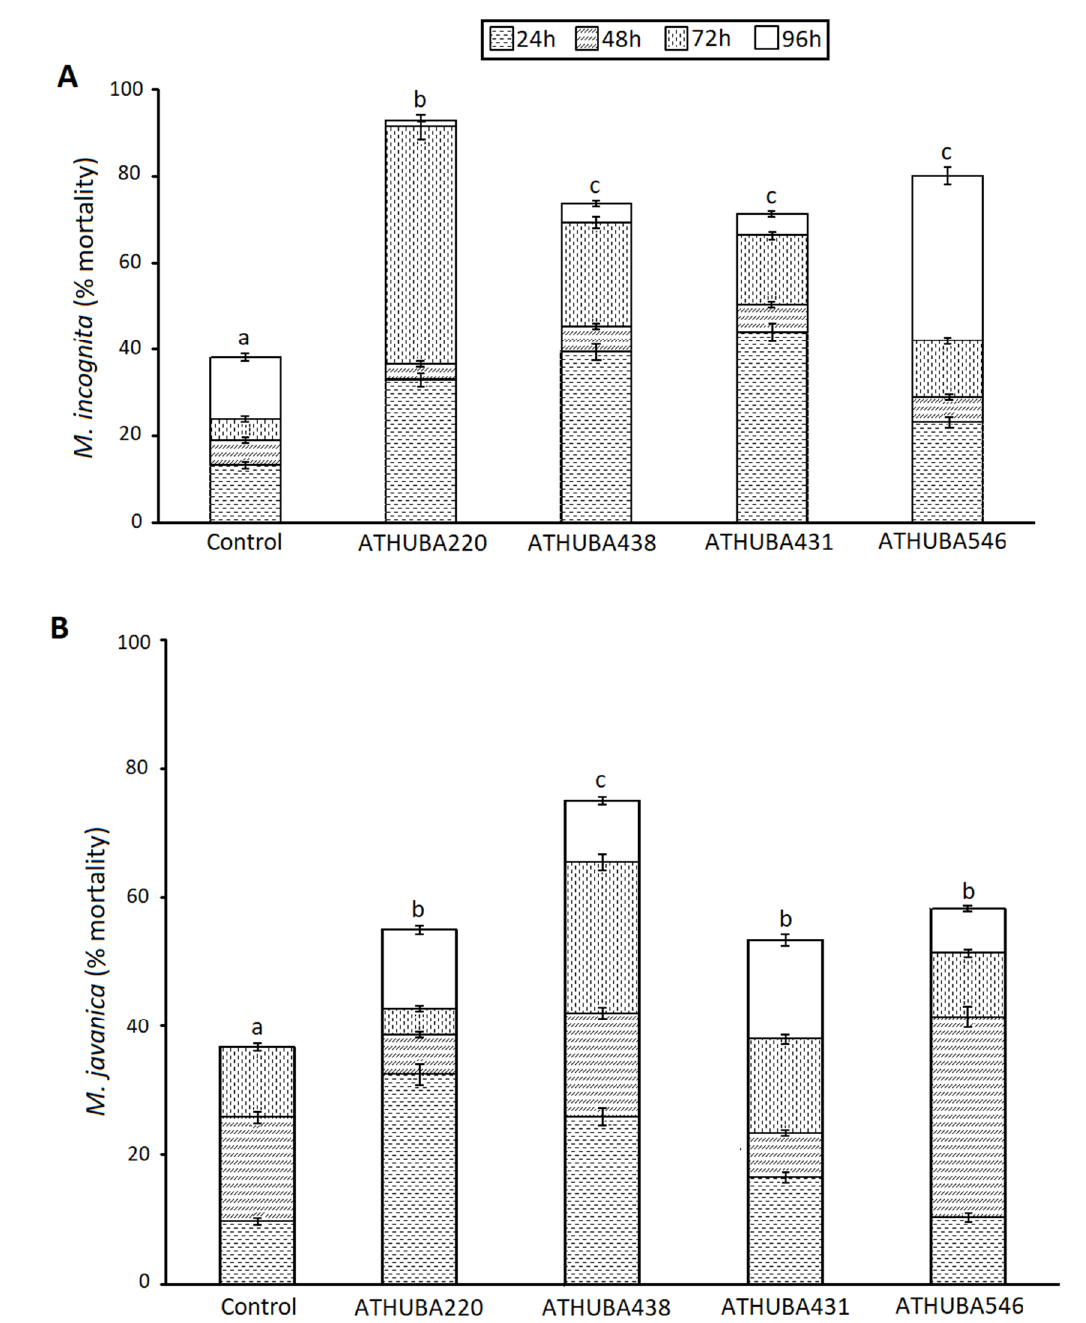
Figure 1. Percentage (mean ± standard error) of J2 mortality in Meloidogyne incognita ( A ) and M. javanica ( B ) after 96 h into batch culture supernatants of different Streptomyces strains as depicted. Different letters above columns correspond to statistically significant differences between Streptomyces strains (one-way ANOVA, Tukey’s test at p < 0.05; for all cases n = 15–20).